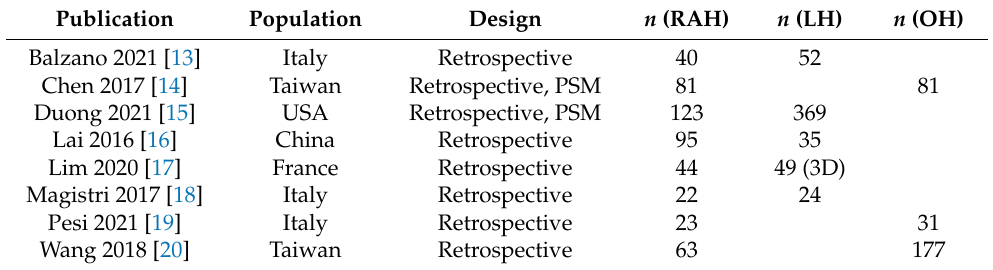
Table 1. Overview of included studies.